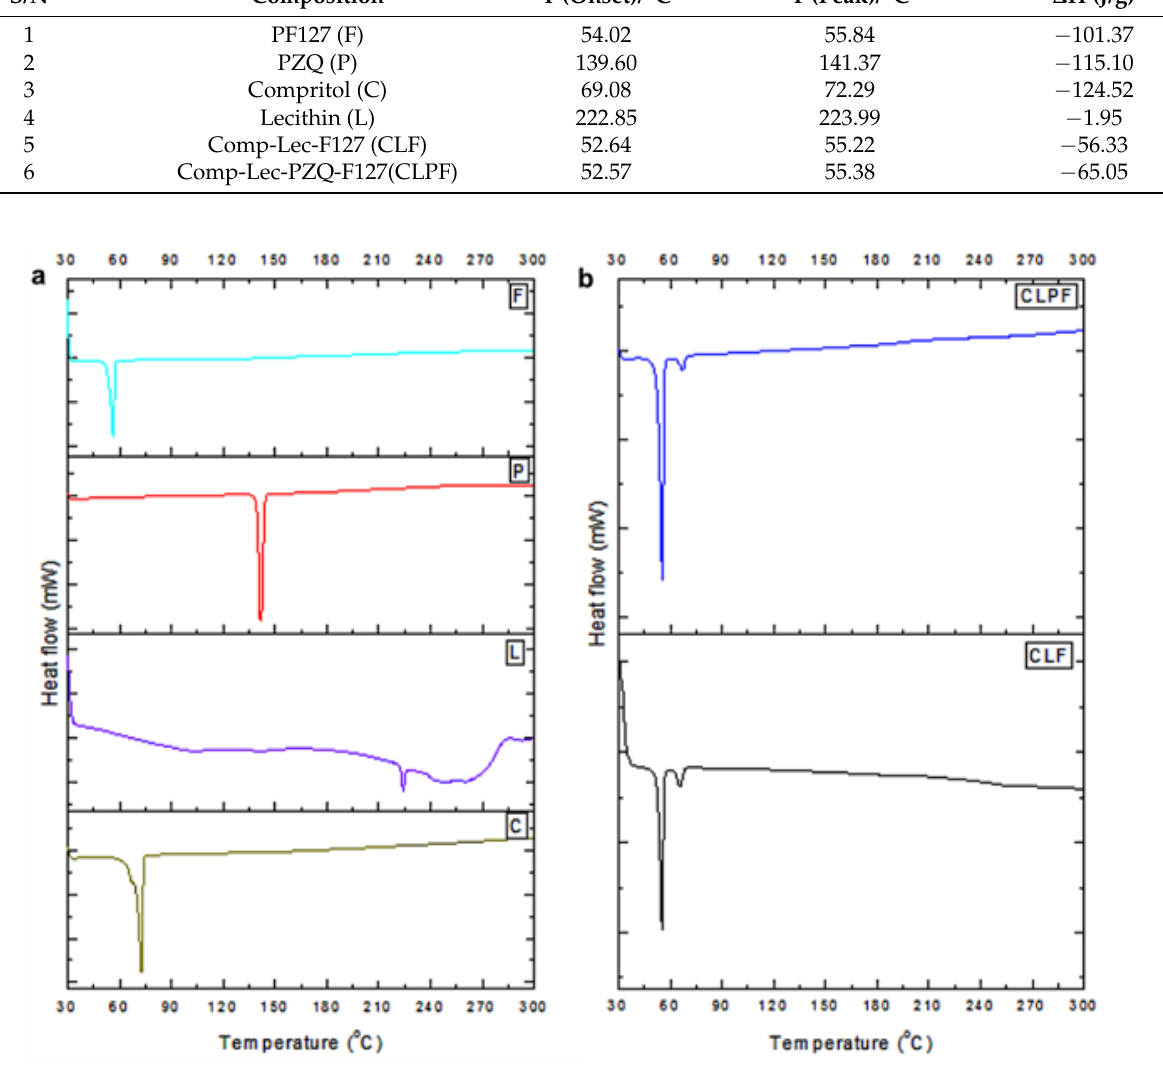
Figure 5. ( a ) DSC thermograms of all the raw excipients F-PF127, P-Praziquantel, L-Lecithin, C- Compritol; ( b ) the formulated unloaded and PZQ-loaded SLNs. Table 2. The summary of the DSC thermogram data of all the excipients and the formulated un- loaded and PZQ-loaded SLNs.